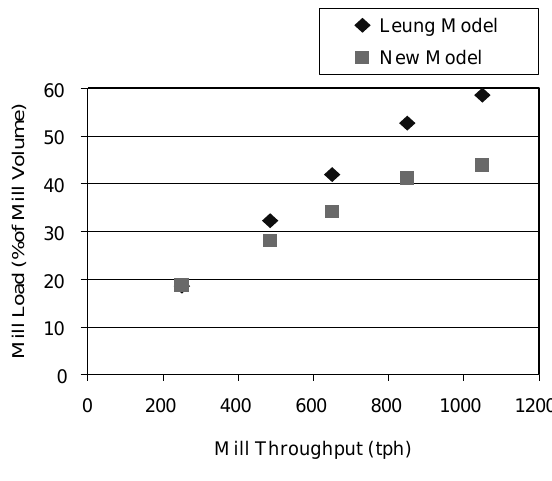
Fig. 10 Relationship Between Mill Load and